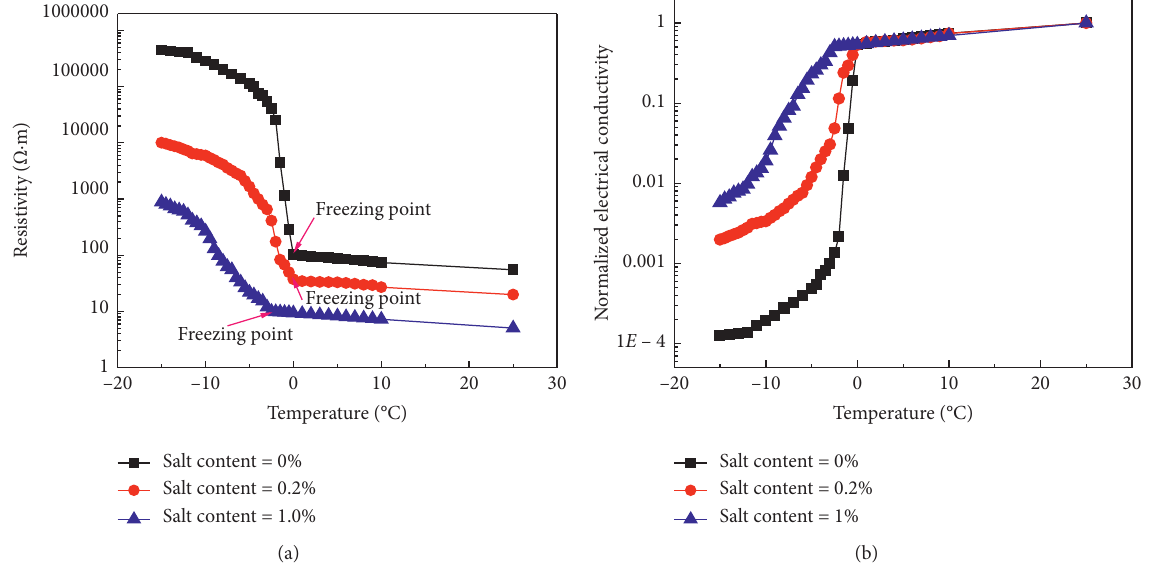
Figure 4: Electrical response during freezing. (a) Electrical resistivity. (b) Electrical conductivity.